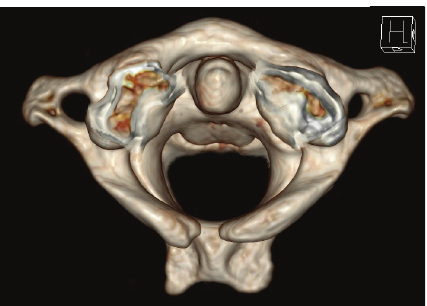
Figure 1: Typical dorsal arch defect (according to Currarino et al. type A [2]).